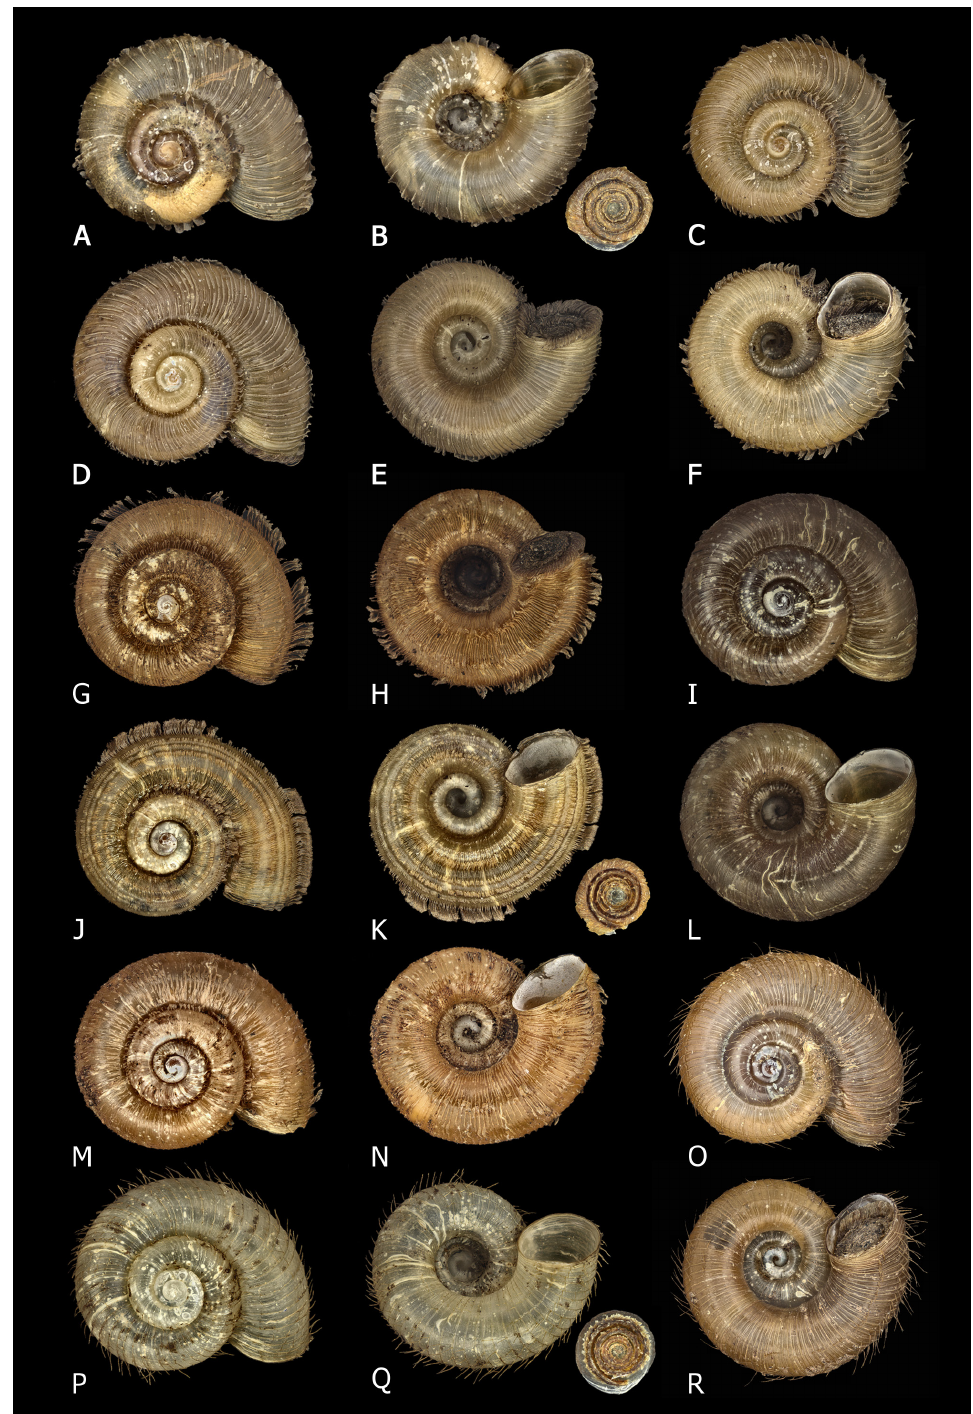
Fig. 10. Holotypes of species of Chondrocyclus Ancey, 1898. A–B . C. herberti sp. nov., diameter 3.70 mm (NMSA P1043/T4277). C, F . C. silvicolus sp. nov., diameter 5.82 mm (NMSA